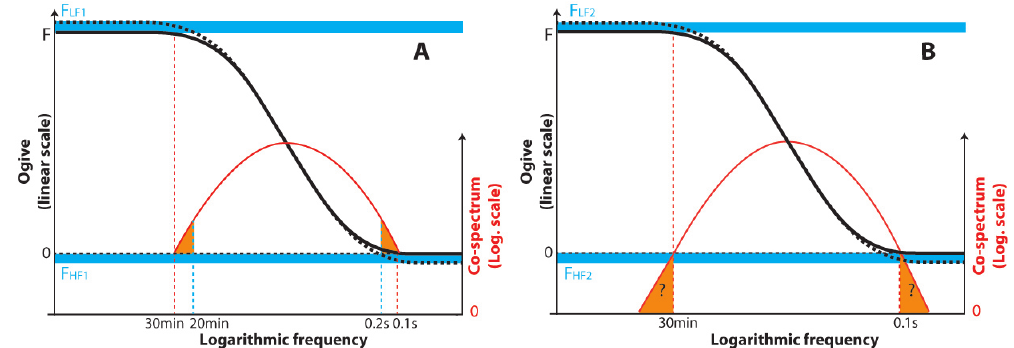
Figure 3. Theoretical cospectra (red line) and equivalent ogives (black line) are shown for two cases: (a) instrument limitations (10Hz as opposed to 20Hz observation frequency) and insufficient flux averaging time (20min as opposed to 30min), both marked in blue/red dashed lines, may result in underestimation of the outer parts of the flux spectrum. The missing cospectral area and ogive range ( F LF1 and F HF1 ) is marked in orange and in blue respectively. The corrected ogive is shown as a dashed black line. (b) Equivalently, if assuming the model is valid beyond 30min and an observational frequency of 20Hz respectively, the flux is likely somewhat underestimated using conventional methods, giving rise to additional ogive correction terms ( F LF2 and F HF2 ) . Although illustrated similarly, generally F LF1 (cid:54)= F LF2 and F HF1 (cid:54)= F HF2